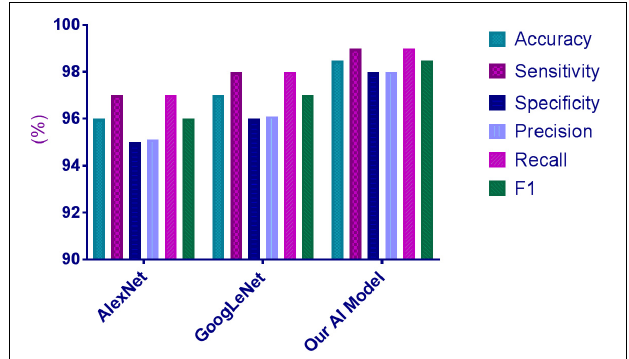
FIGURE 3 | Performances of the proposed AI model and other architectures for HCC